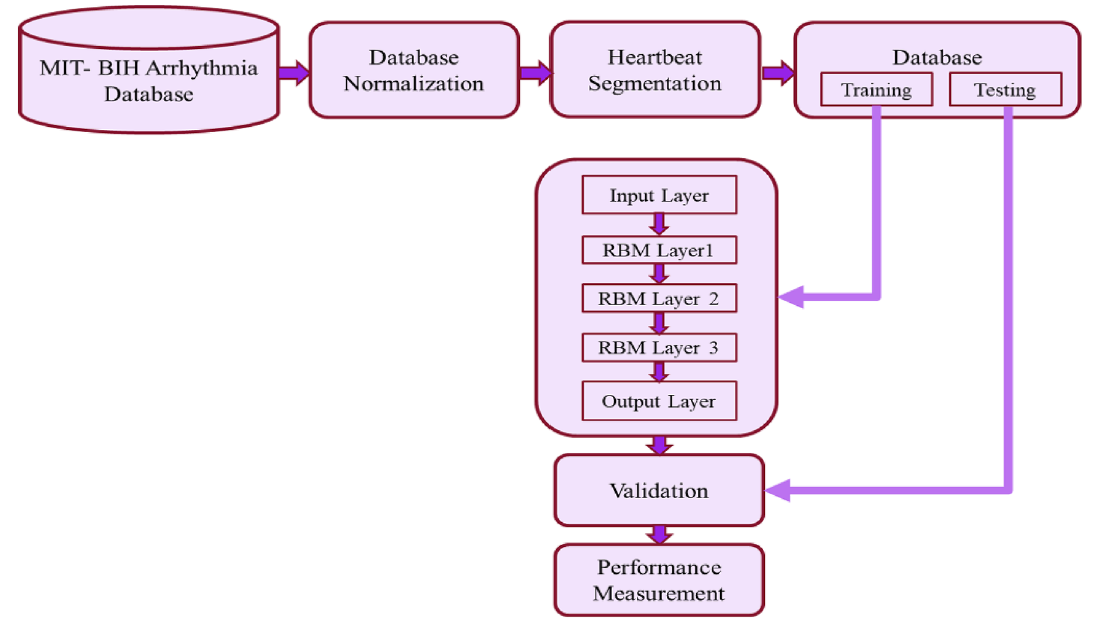
Fig. 2 Workflow Diagram of RBM Model for classification of ECG signal